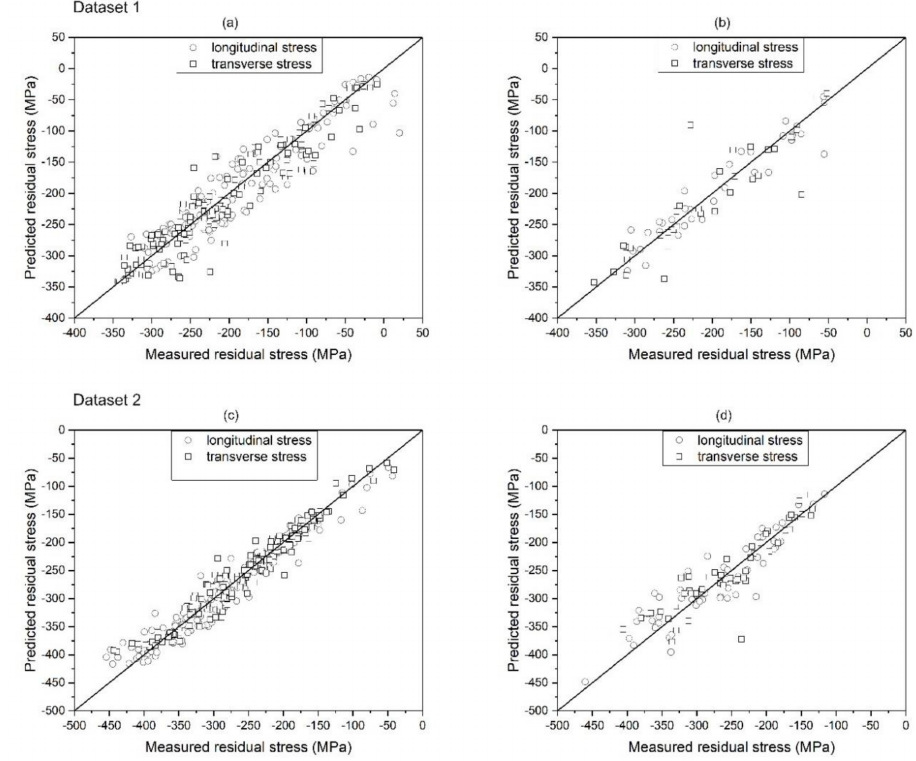
Figure 7. Comparison of predicted and measured residual stresses in longitudinal (datapoint denoted as square) and transverse (datapoint denoted as circle) directions with linear fitting for ( a ) training data and ( b ) test data using single-shot laser peening data (dataset 1), as well as ( c ) training data and ( d ) test data using multiple-shot laser peening data with overlap (dataset 2).